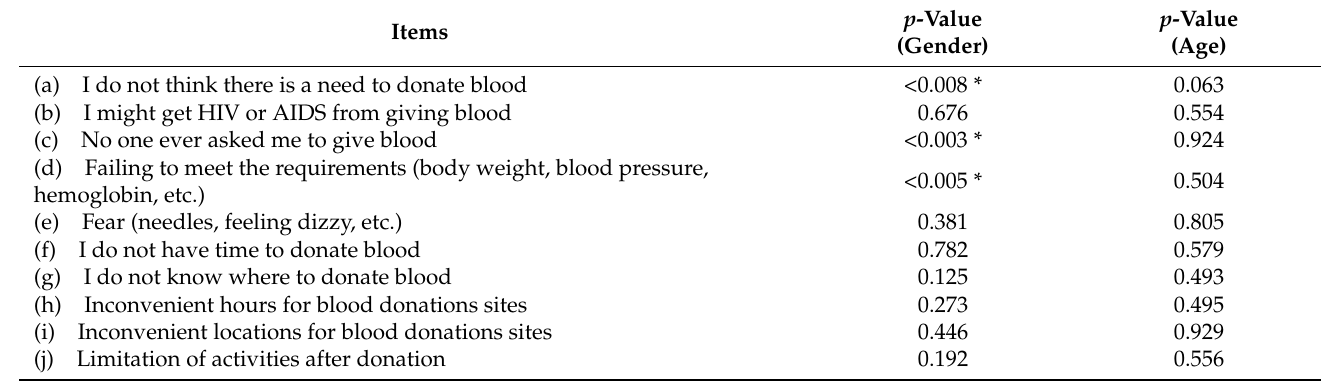
Table 6. Association between gender/age and blood donation